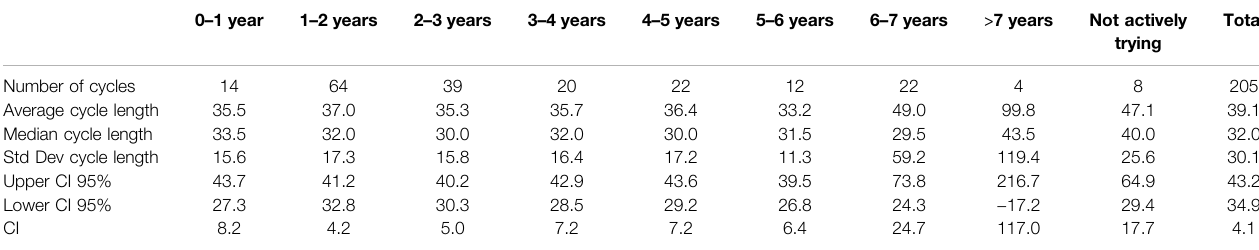
TABLE 1 | Study population cycle comparison by number of years trying to